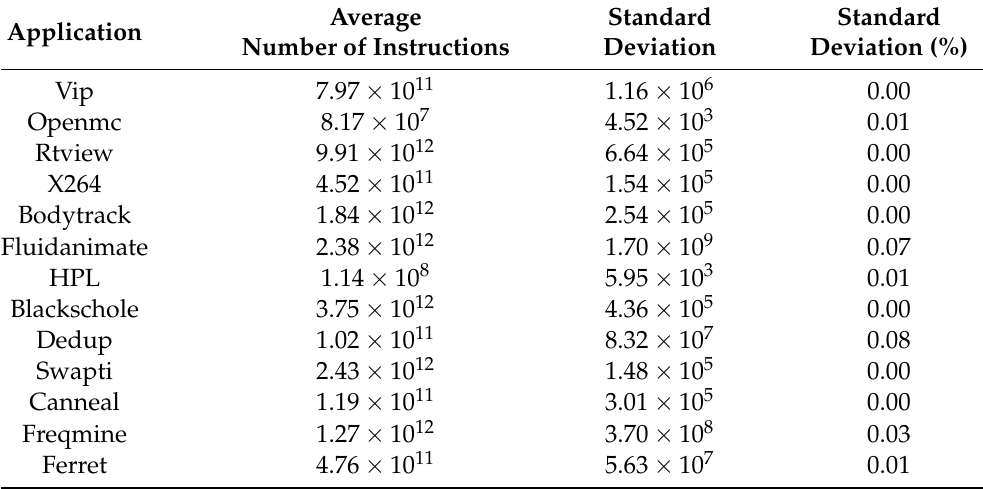
Table 4. Variation of the number of instructions when changing the frequency for the same